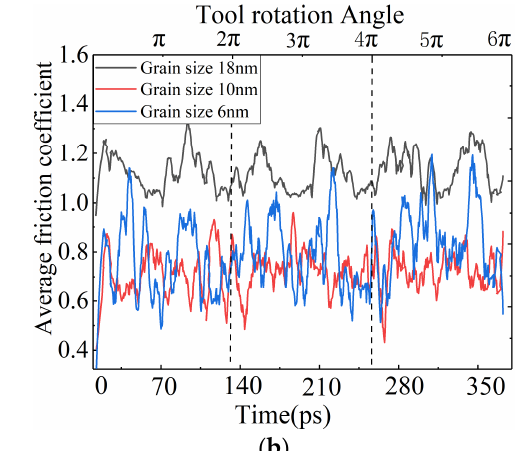
( b ) Figure 15. Friction of different grain size of the workpiece: ( a ) is the depth diagram of grinding groove after three frictions at different grain sizes, and ( b ) is the atomic number diagram of abrasive debris discharged at different grain sizes.